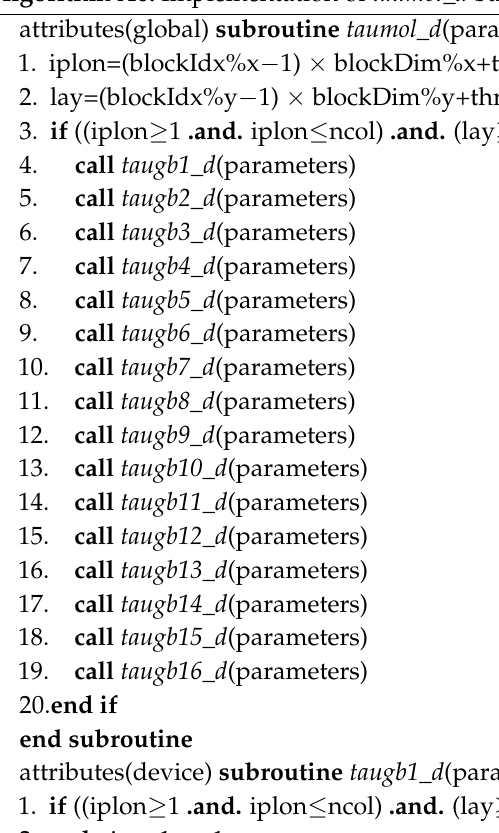
Algorithm A6: Implementation of taumol_d based on CUDA Fortran in 2-D decomposition. attributes(global) subroutine taumol_d